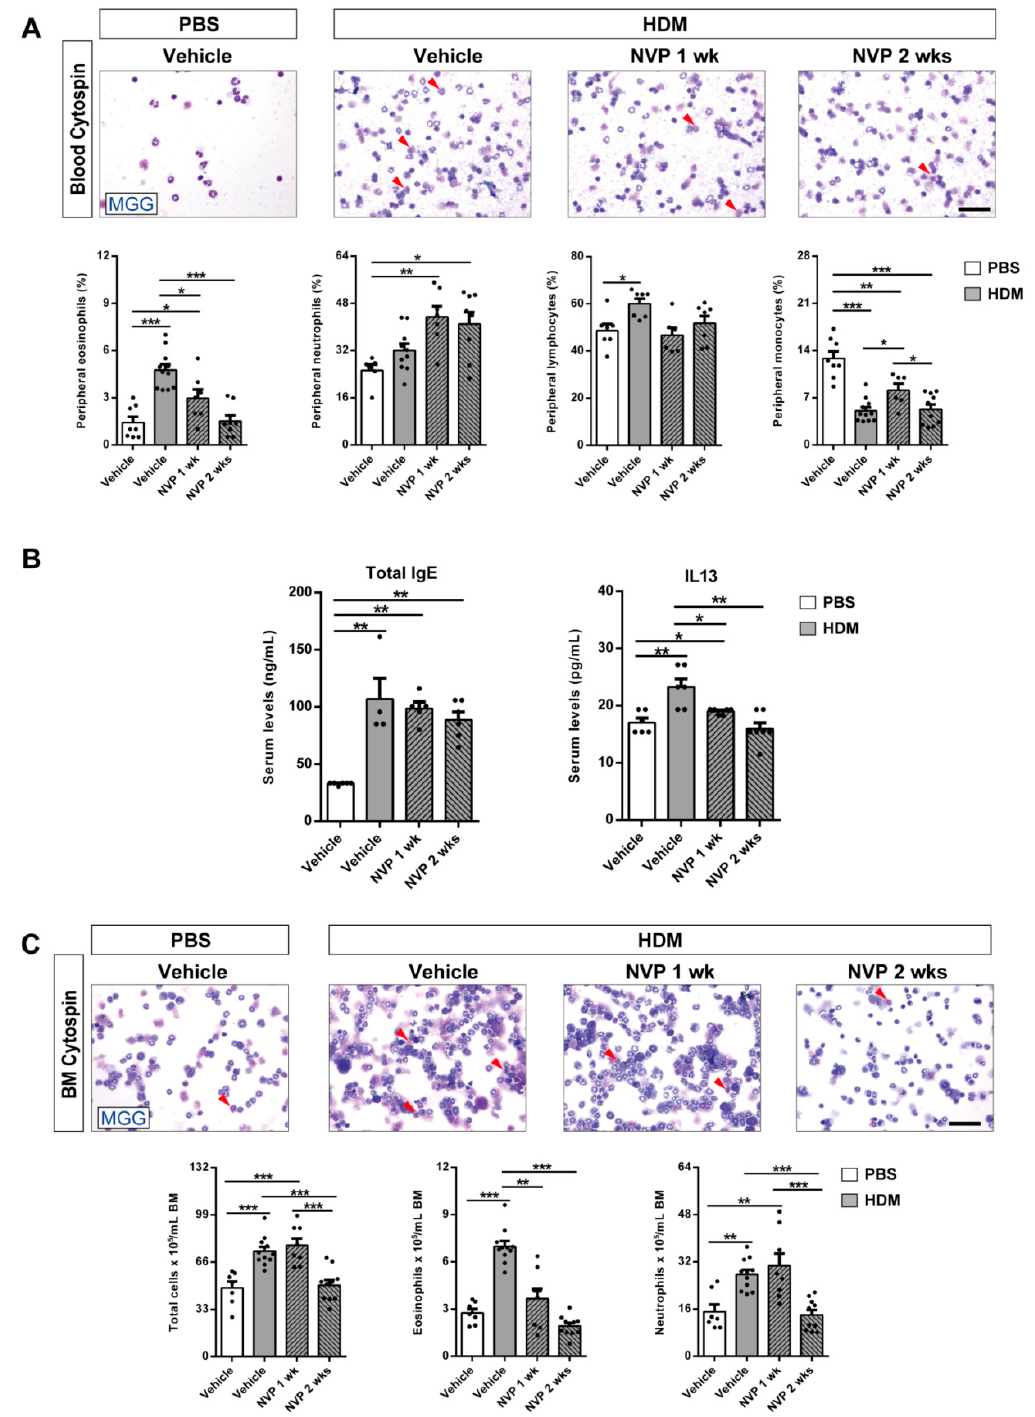
Figure 2. Pharmacological blockade of IGF1R depletes eosinophil presence in peripheral blood and bone marrow and attenuates the increase in serum IL13 levels after HDM exposure. ( A , C ) Representative images showing May-Grünwald/Giemsa (MGG) stained peripheral blood and bone marrow cytospin preparations (red arrowheads indicate eosinophils), and differential cell counts for eosinophils, neutrophils, lymphocytes and monocytes in peripheral blood ( A ), and total cells, eosinophils and neutrophils in bone marrow ( C ) from HDM-challenged mice treated with NVP vs. controls ( n = 7–10 mice per group; scale bars: 50 μ m). ( B ) Total serum IgE and IL13 levels from HDM-challenged mice treated with NVP vs. controls ( n = 5–7 mice per group). Data are expressed as mean ± SEM. * p < 0.05; ** p < 0.01; *** p < 0.001 (Mann–Whitney U test or Student´s t -test for comparing two groups and Kruskal–Wallis test or ANOVA multiple comparison test for grouped or multivariate analysis).